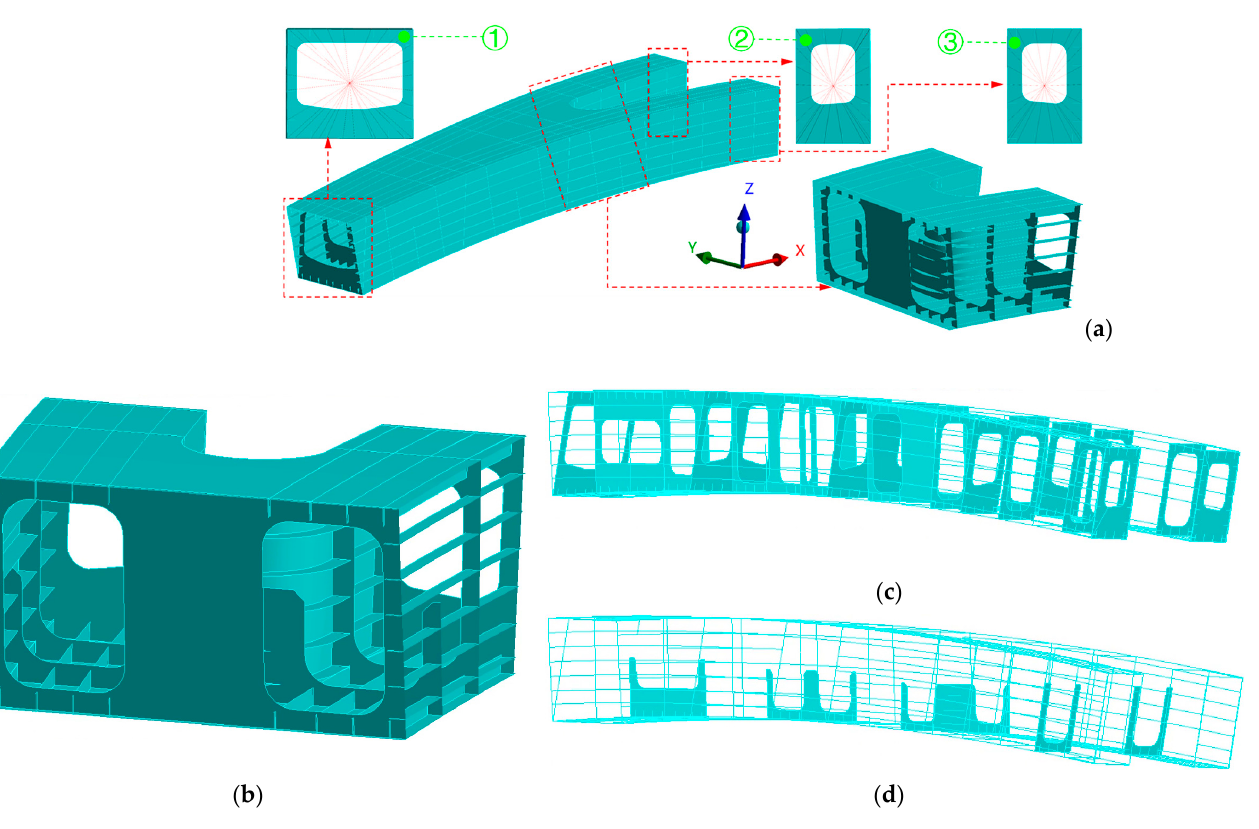
Figure 15. Spatial finite element model of bifurcation segment of main arch rib: ( a ) overall bifurcation segment; ( b ) Y-block; ( c ) A-type diaphragm; ( d ) B-type diaphragm.